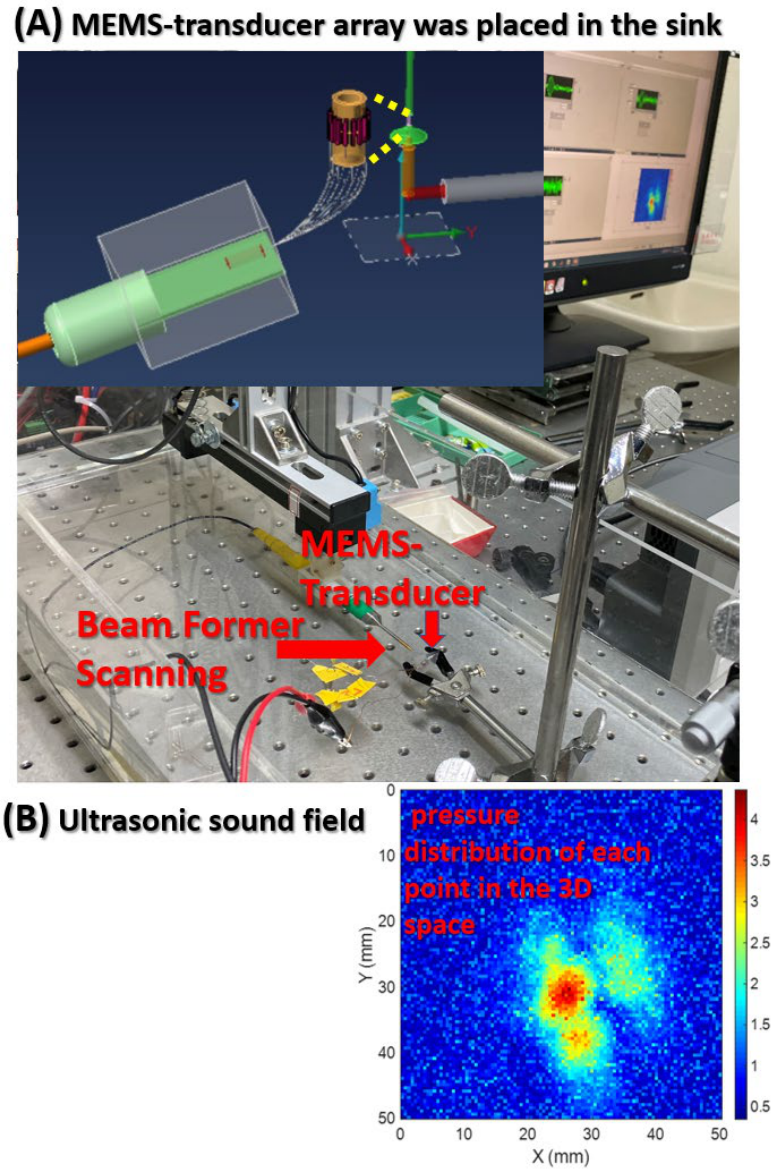
Figure 4. Beamforming was performed to scan the ultrasonic resonance energy of the MEMS-transducer. ( A ) The 16-channel circular MEMS-transducer array was placed in the sink for ultrasonic signal monitoring. ( B ) 10.00 Vpp signals were sent to Channel 5 at a frequency of 2.3759 MHz. Beamforming was performed to detect ultrasound signals, as shown in Figure 4.